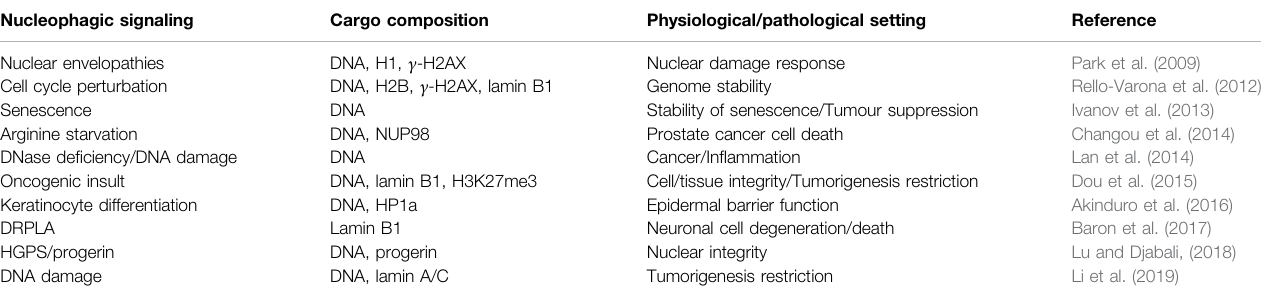
TABLE 1 | Nucleophagy in